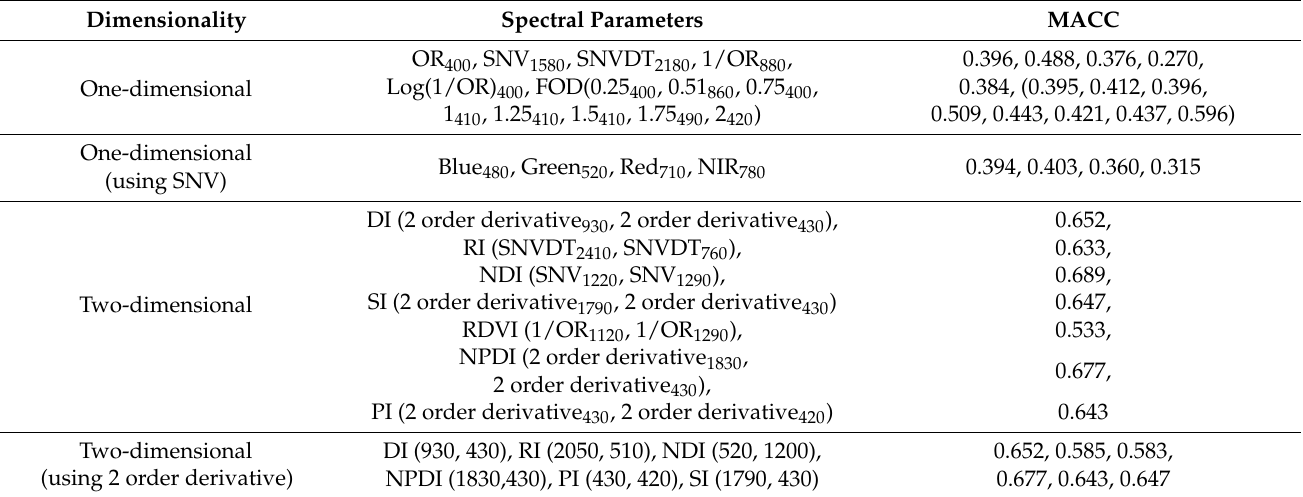
Table 4. Most sensitive spectral parameters by one- and two-dimensional correlation coefficients.